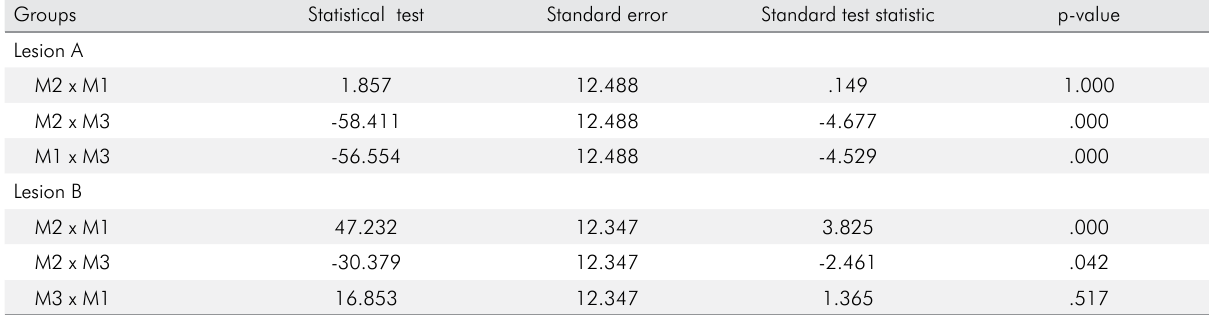
Table 3. Analysis between groups (M1, M2 and M3) for the items considered essential for the process of setting priorities for lesions A and B, performed by the Dunn’s test.